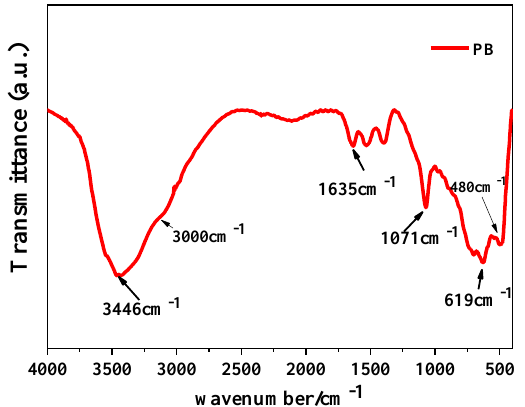
Figure 9. FT-IR results of PB (concentration of NaAlO 2 solution, 0.1 mol/L; gas – liquid ratio, 3:1; rotating speed of CF-RPB, 600 rpm).